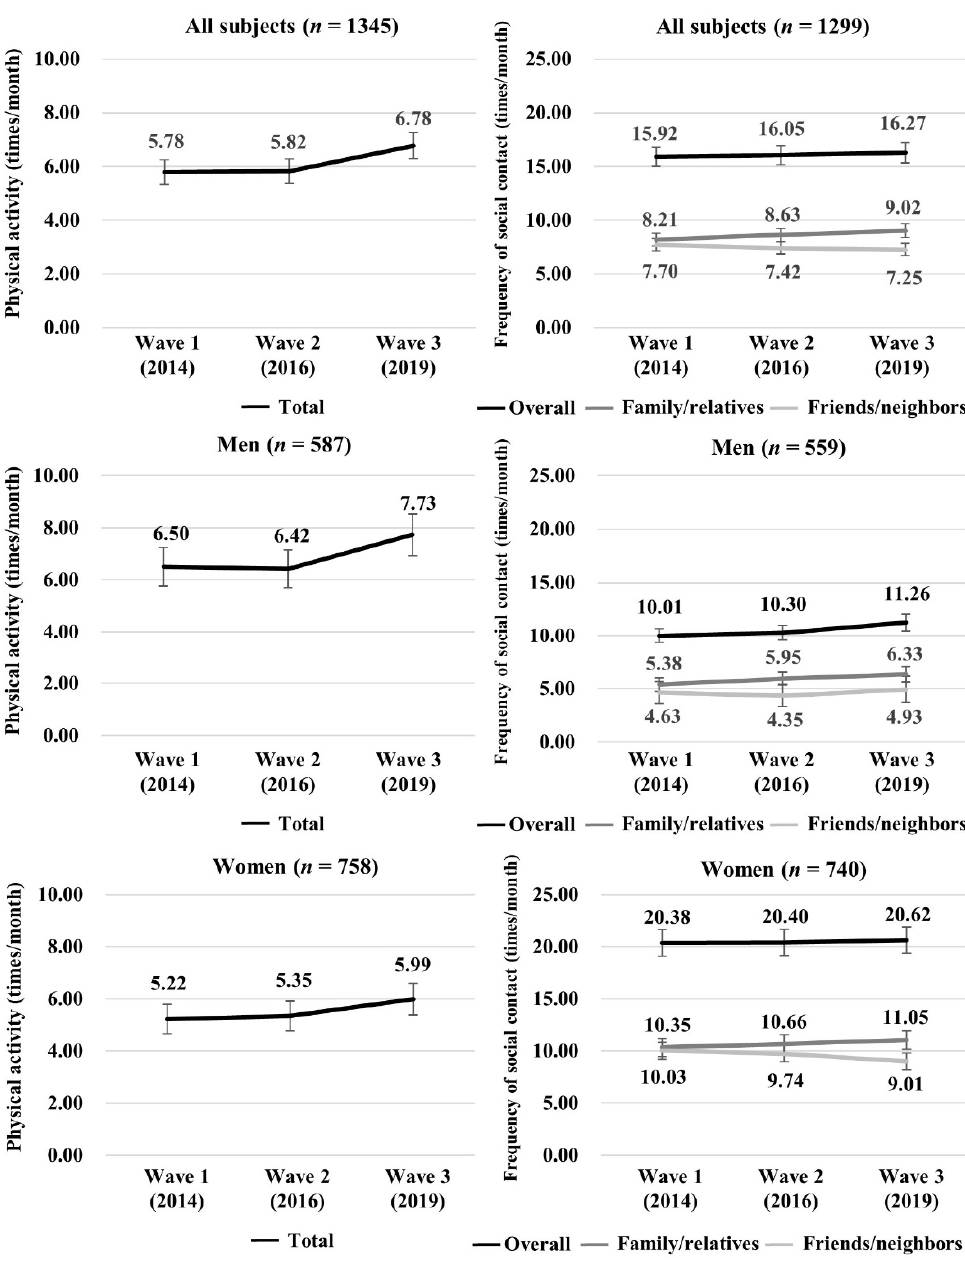
Figure 3. Changes in physical activity and social contact over five years among Japanese adults. The results of the latent growth curve model, examining the association of social contact with PA, are shown in Table 2. All fit indicators showed a good model fit to the data.